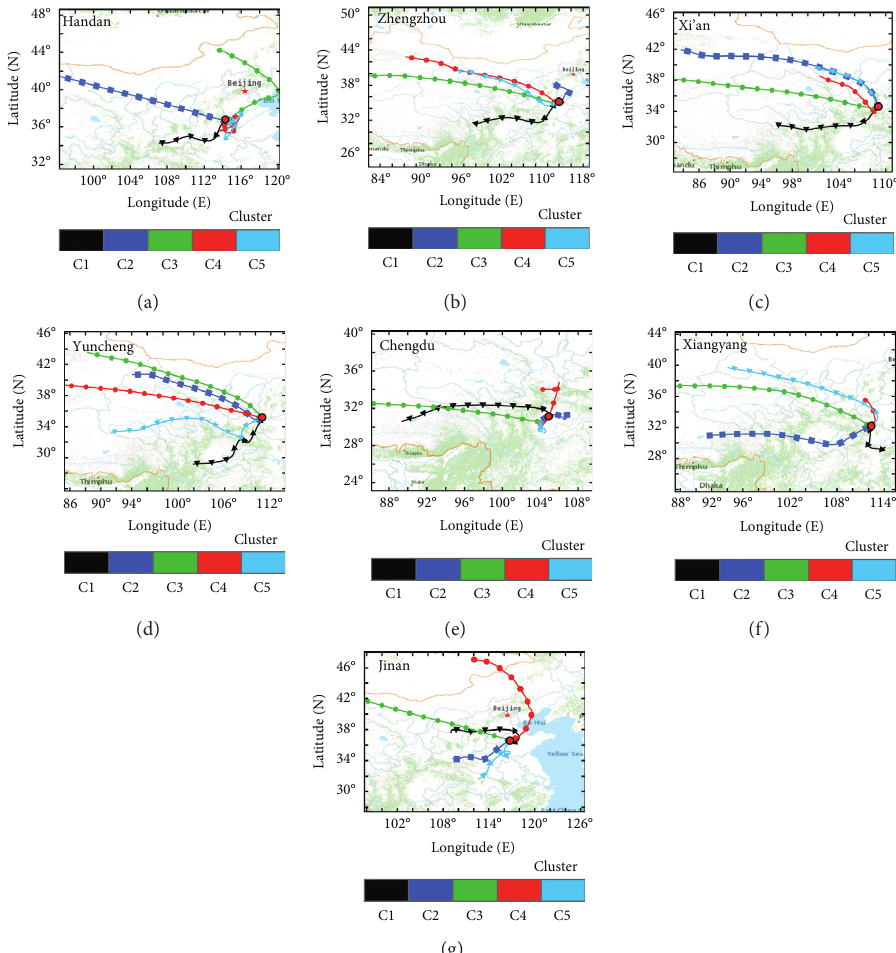
Figure 7: Spatial distribution of cluster means in seven Chinese cities, with the large red dots representing cities.